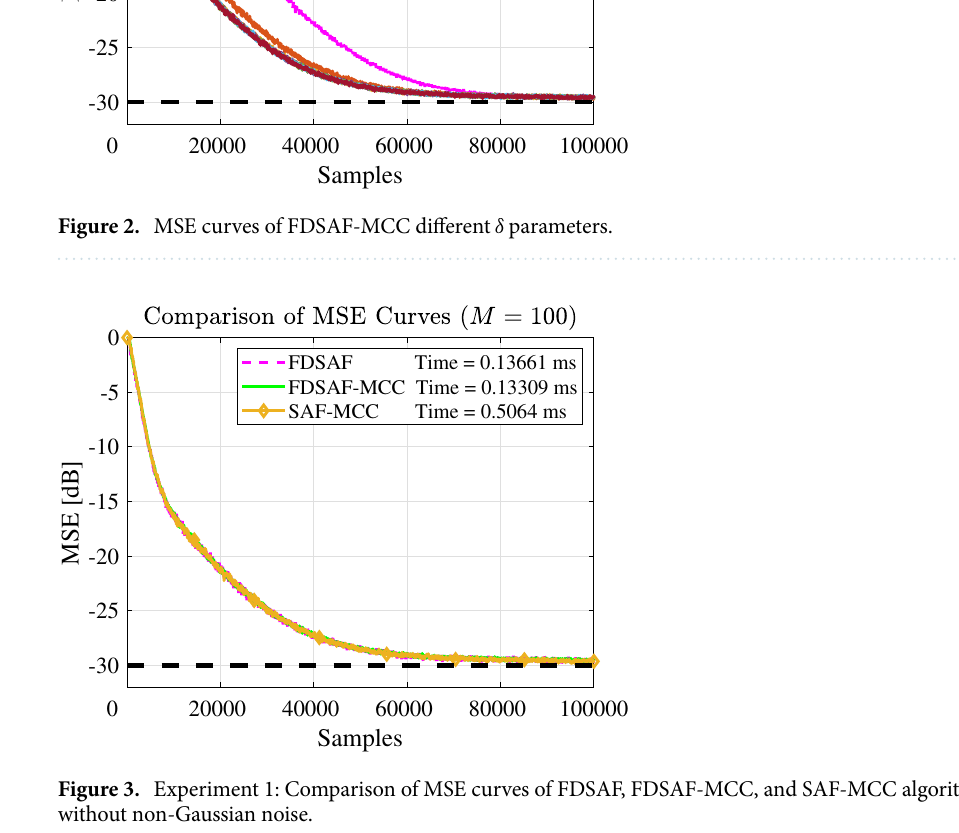
Figure 7 shown the MSE curves comparison between FDSAF, the proposed FDSAF-MCC, and SAF-MCC under non-Gaussian noise and a sudden change. The proposed FDSAF-MCC and SAF-MCC algorithms have better convergence performance. After a sudden change, the MSE curve converges of the FDSAF-MCC and the SAF-MCC algorithms, the MSE curve divergent of the FDSAF algorithm. Experiment 2.